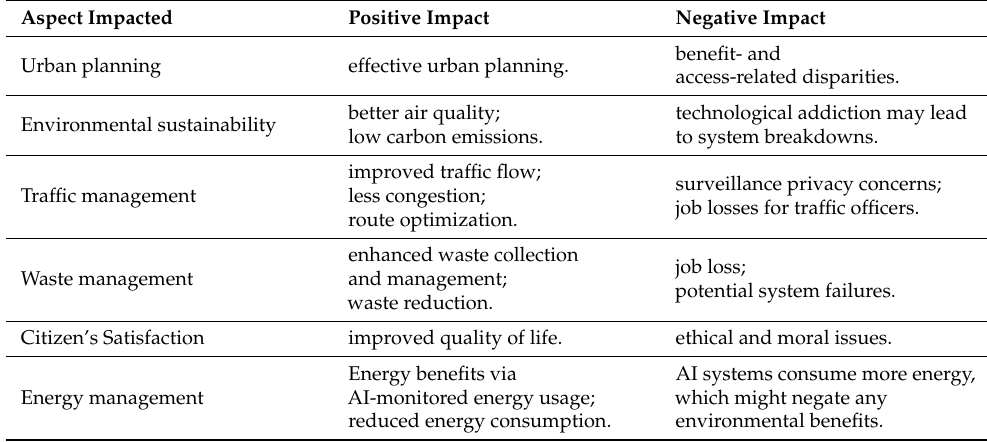
Table 14. The positive and negative impacts of AI as a disruptive technology on smart